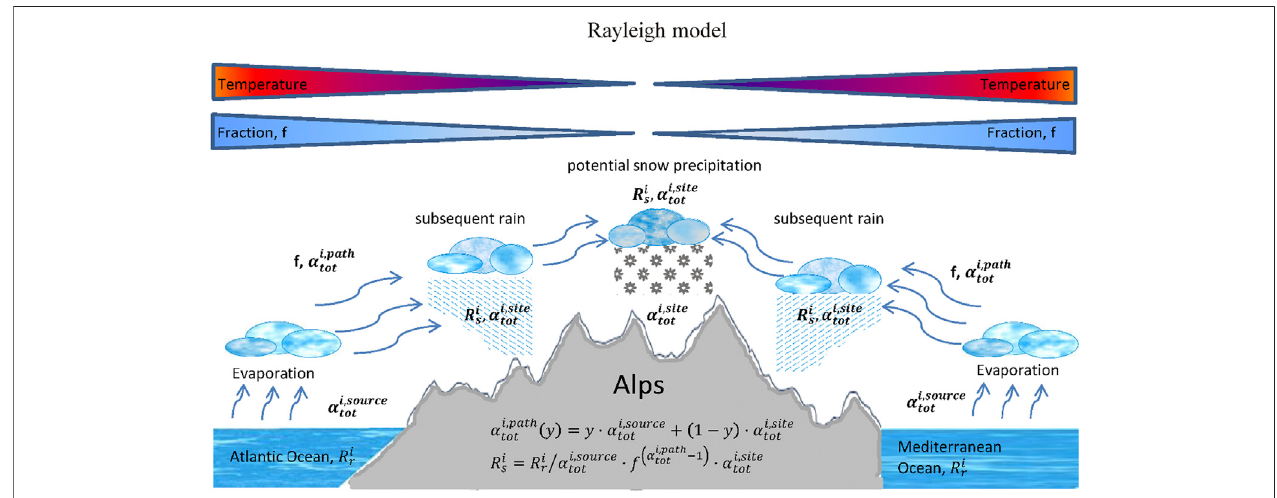
FIGURE 5 | Conceptual scheme of a simple Rayleigh approach to characterize the source and site conditions using the seven Swiss precipitation sites. Fractionations at the source, along the air trajectory and at the site are included, all fractionations are subject to a combination of temperature dependent equilibrium fractionations and humidity and turbulence factor dependent kinetic fractionations.